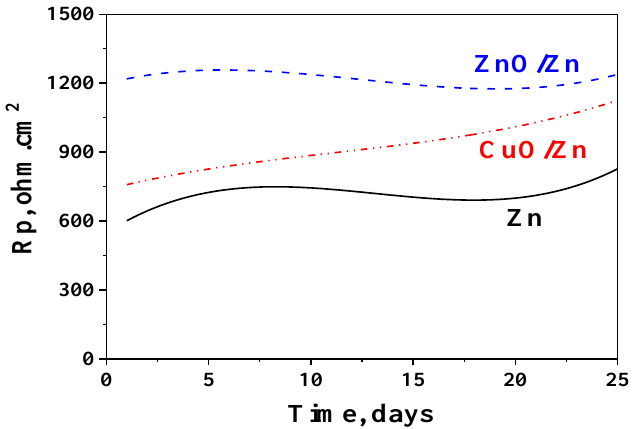
Figure 4. Polarization resistance (Rp) measurements of ordinary Zn and of both hybrid coatings in the model corrosive medium of 5% NaCl.